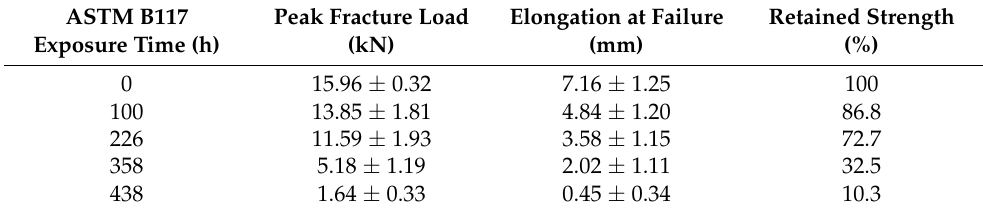
Table 3. Summary of lap shear tensile testing for the as-bolted CFRC-AZ31B joints.